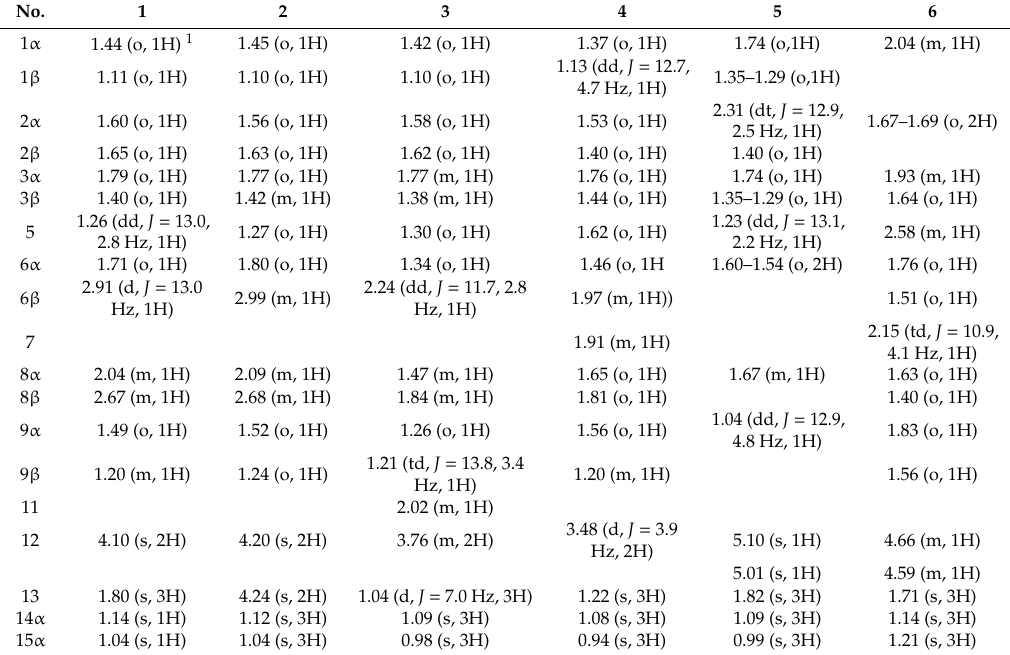
Table 1. 1 H-NMR spectral data of 1 – 6 .